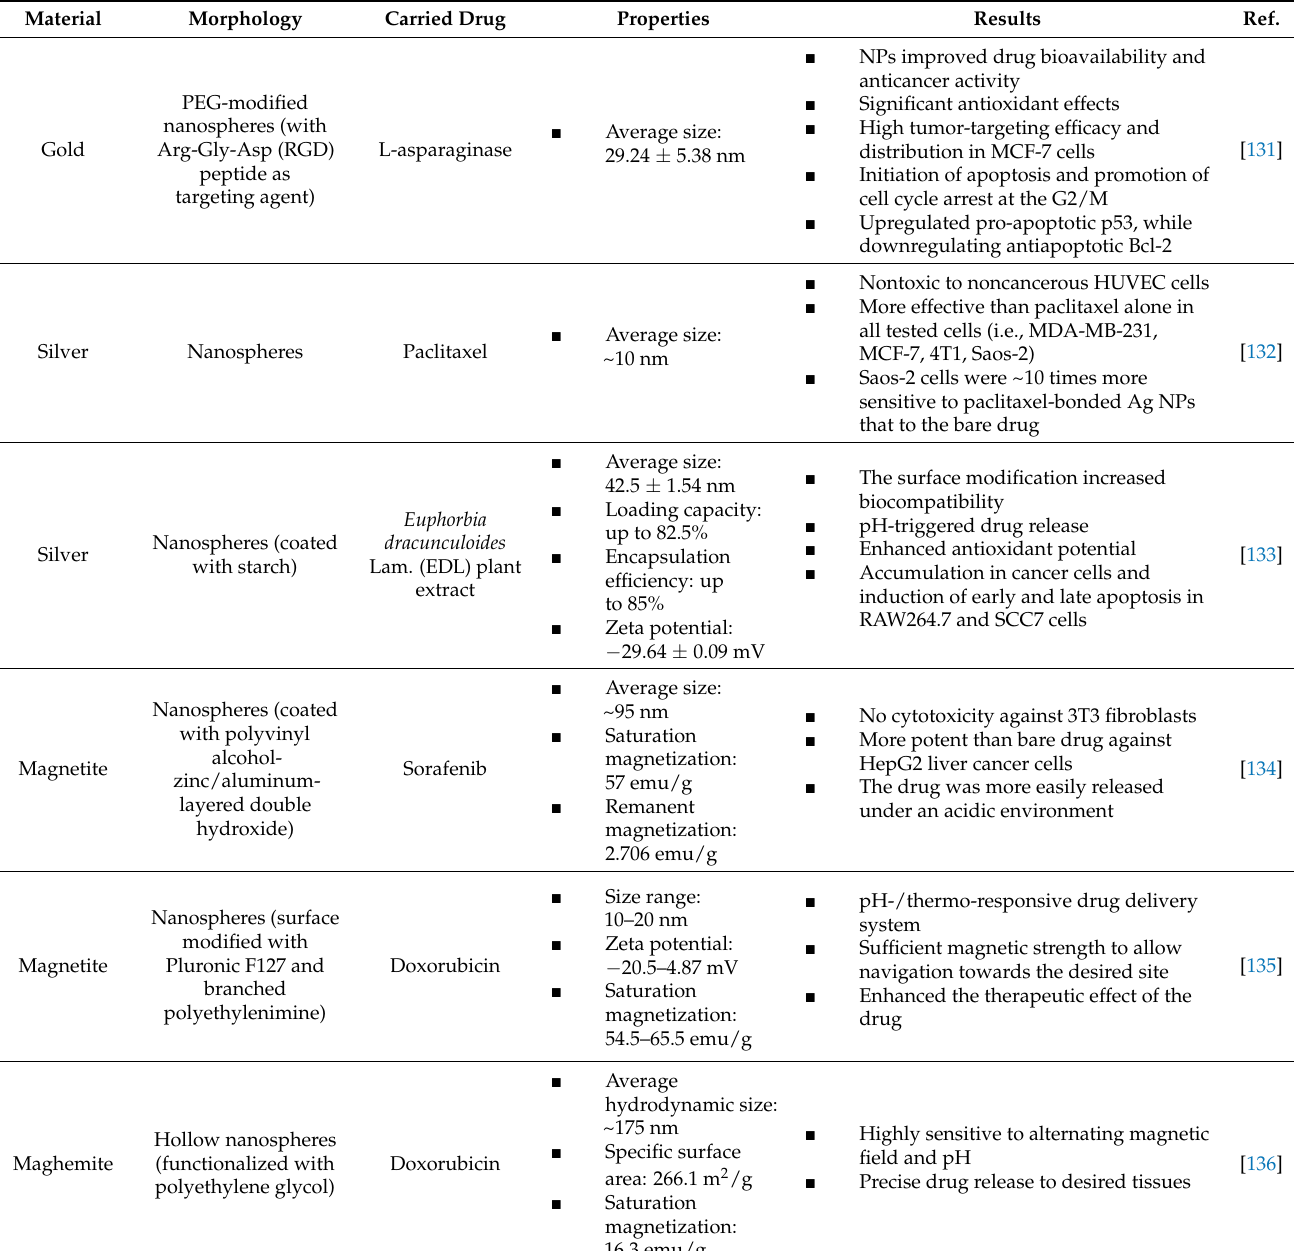
Table 2. Examples of recently developed metal-based drug delivery systems for cancer